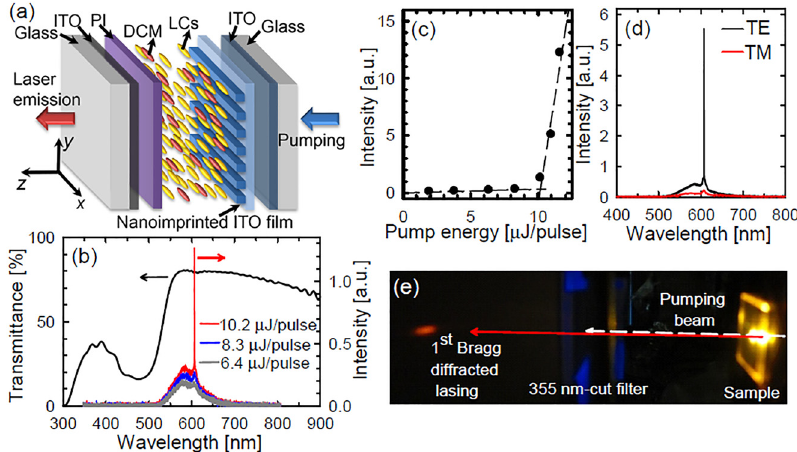
Figure 9: (a) Schematic illustration, (b) transmission and emission spectra at different pumping energies, (c) threshold behavior of lasing emission intensity, (d) polarized lasing emission spectra at the pumping energy of 11.6 μ J/pulse, and (e) photograph of far- fi eld emission pattern of the surface-emitting DFB laser with the nanoimprinted ITO electrode and dye- doped LCs